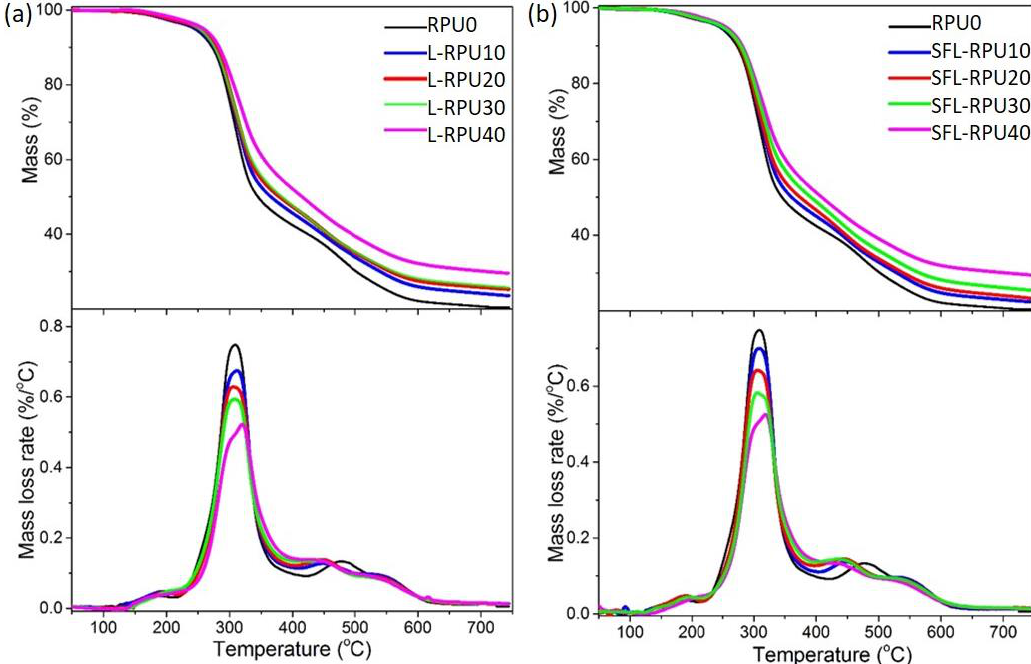
Figure 7. Thermogravimetry (TG) and the maximum derivative thermogravimetric (DTG) curves of L-RPU ( a ) and SFL-RPU ( b ) foams containing 0–40% lignin.